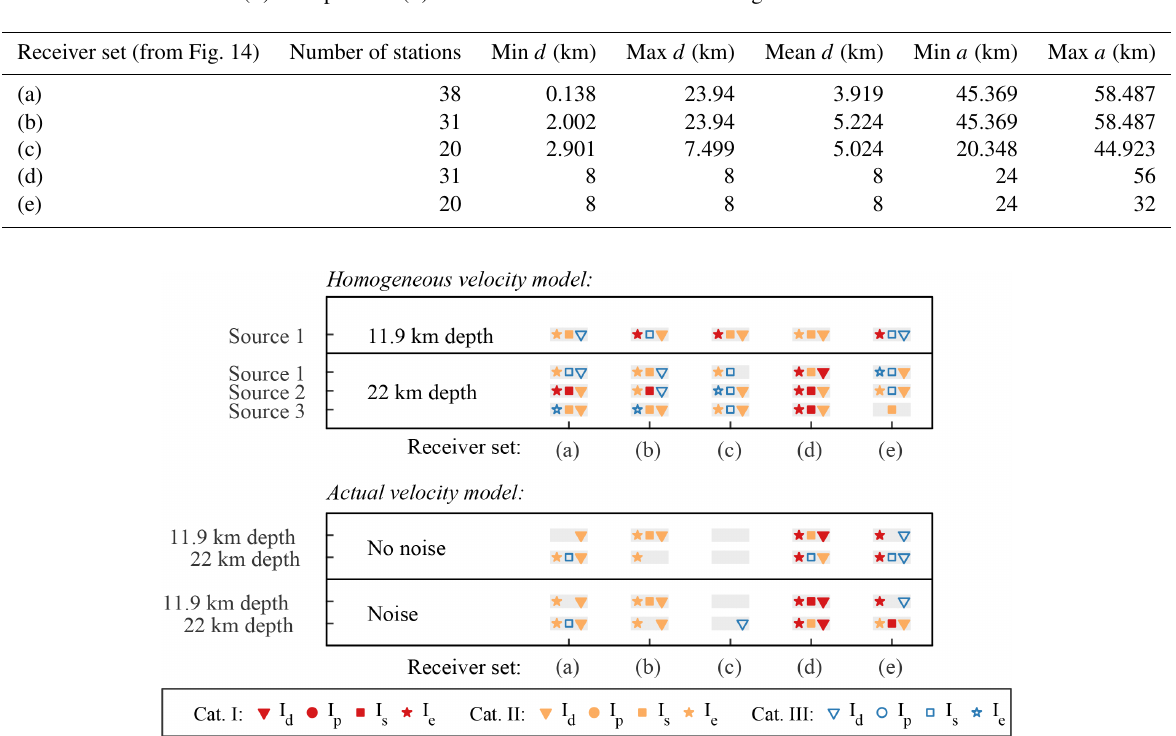
Figure 15. The location accuracy achieved with a strike-slip source at different depths, with the different receiver sets and a homogeneous velocity model (top half) and with the velocity model of Zeng et al. (2016) and added noise (SNR = 1) (bottom half of the figure). The lower case letters represent the receiver sets of Fig. 14. The localisation obtained with the individual imaging conditions were ranked according to the categories from Fig. 2. Grey bars indicate set-ups that were tested. No symbol in the grey bar means the localisation was unsuccessful. Symbol types and colours in the grey bars represent successful locations with the imaging condition sorted into the respective